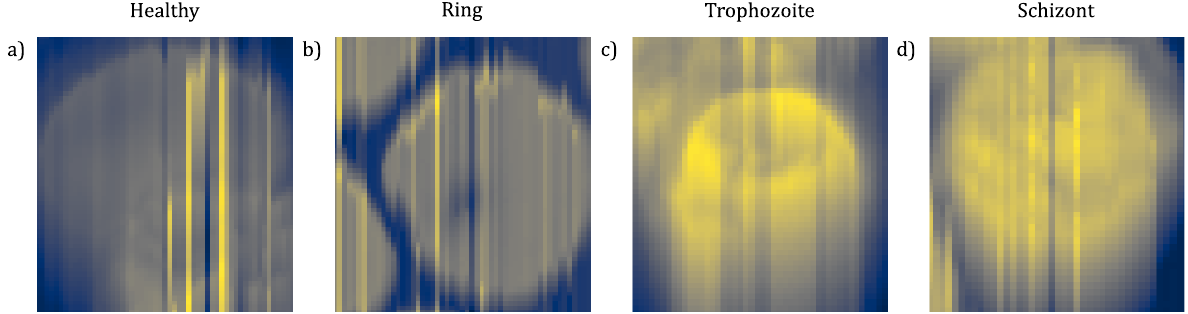
Figure 8. Artefacts in AFM images due to tip contamination. ( a – d ) Representative images for each cell category. All images were classified correctly by the neural network, showing its insensitivity to local variations in